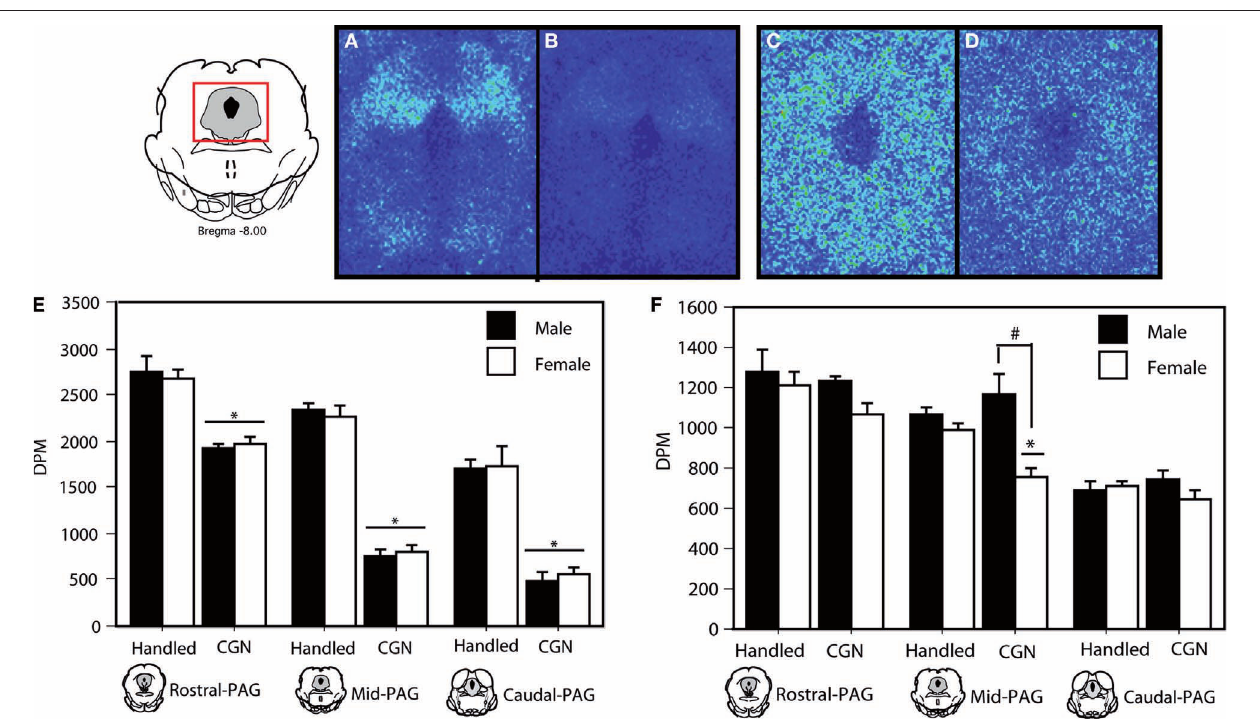
FIGURE 5 | MOR binding in the PAG in adult rats following (A) handling, or (B) 1% carrageenan. DOR binding distribution in the PAG of adult rats following (C) handling, or (D) 1% carrageenan. (E) Neonatally injured (CGN) animals displayed a signifi cant decrease in MOR-binding at all levels of the PAGl/vl compared to handled animals. (F) A signifi cant decrease in